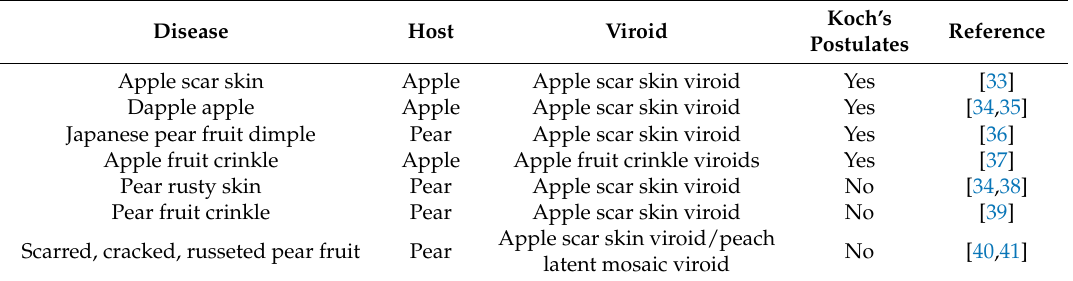
Table 2. Pome and stone fruit diseases caused by or associated with